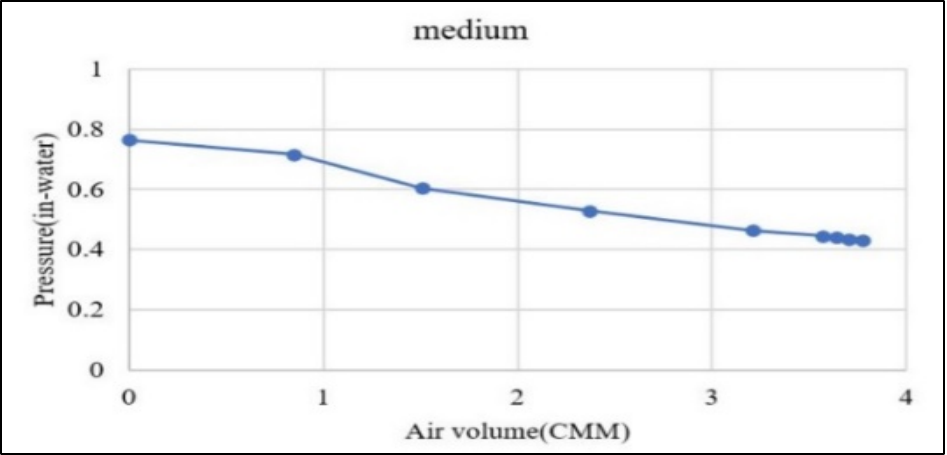
Figure 10. P-Q curve of the air purifier at a medium rotation speed.